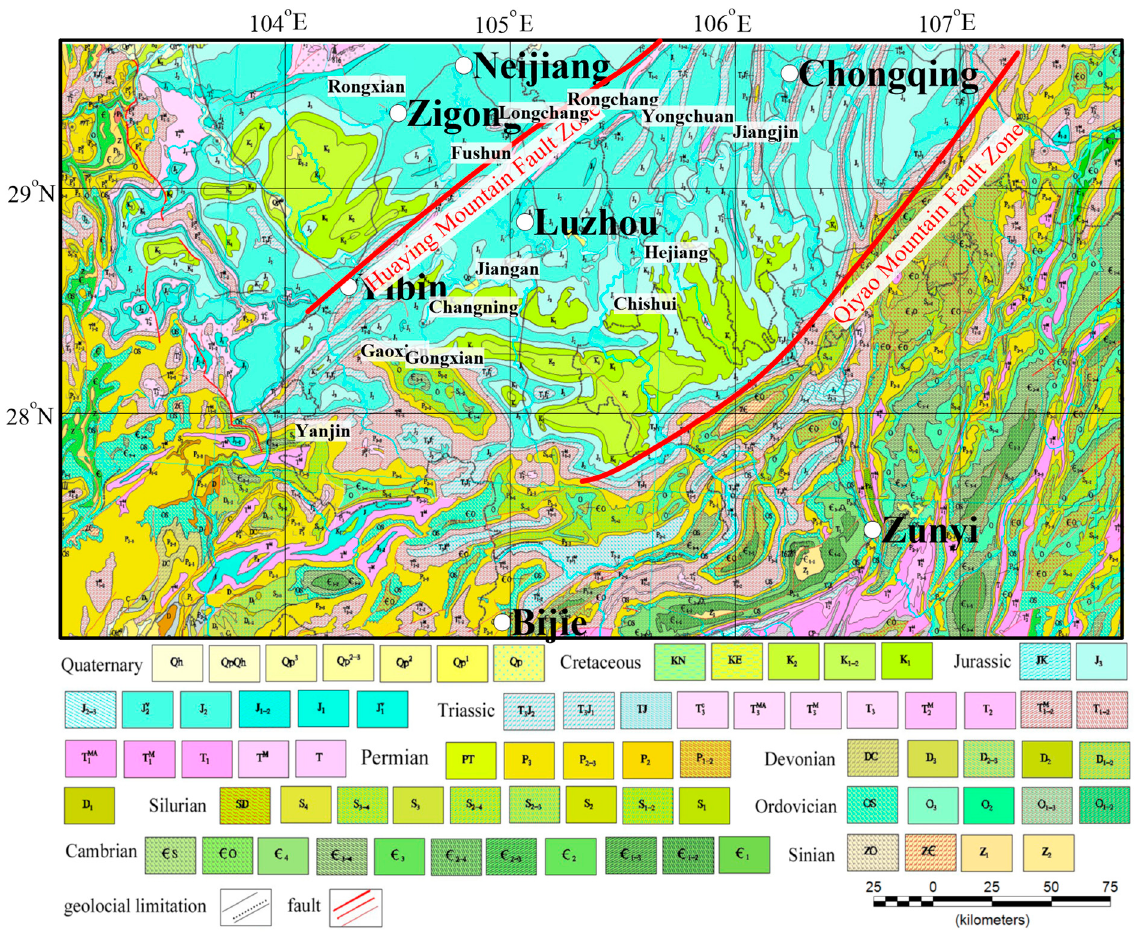
Figure 2. 1:2,500,000 geological map of study area (revised from the Development Research Center of China Geological Survey).